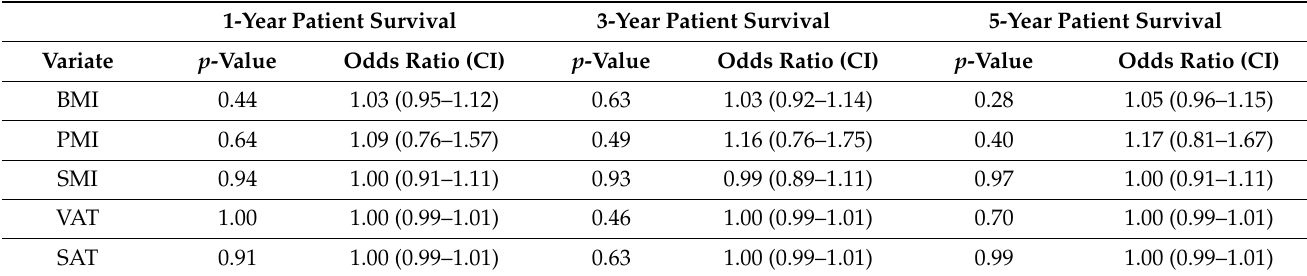
Table 3. Cox regression analysis of 1-year, 3-year and 5-year patient survival with the variates BMI and AI-derived body composition parameters PMI, SMI, VAT and SAT. AI = artificial intelligence, BMI = body mass index, CI = confidence interval, PMI = psoas muscle index, SMI = skeletal muscle index, SAT = subcutaneous adipose tissue, VAT = visceral adipose tissue.